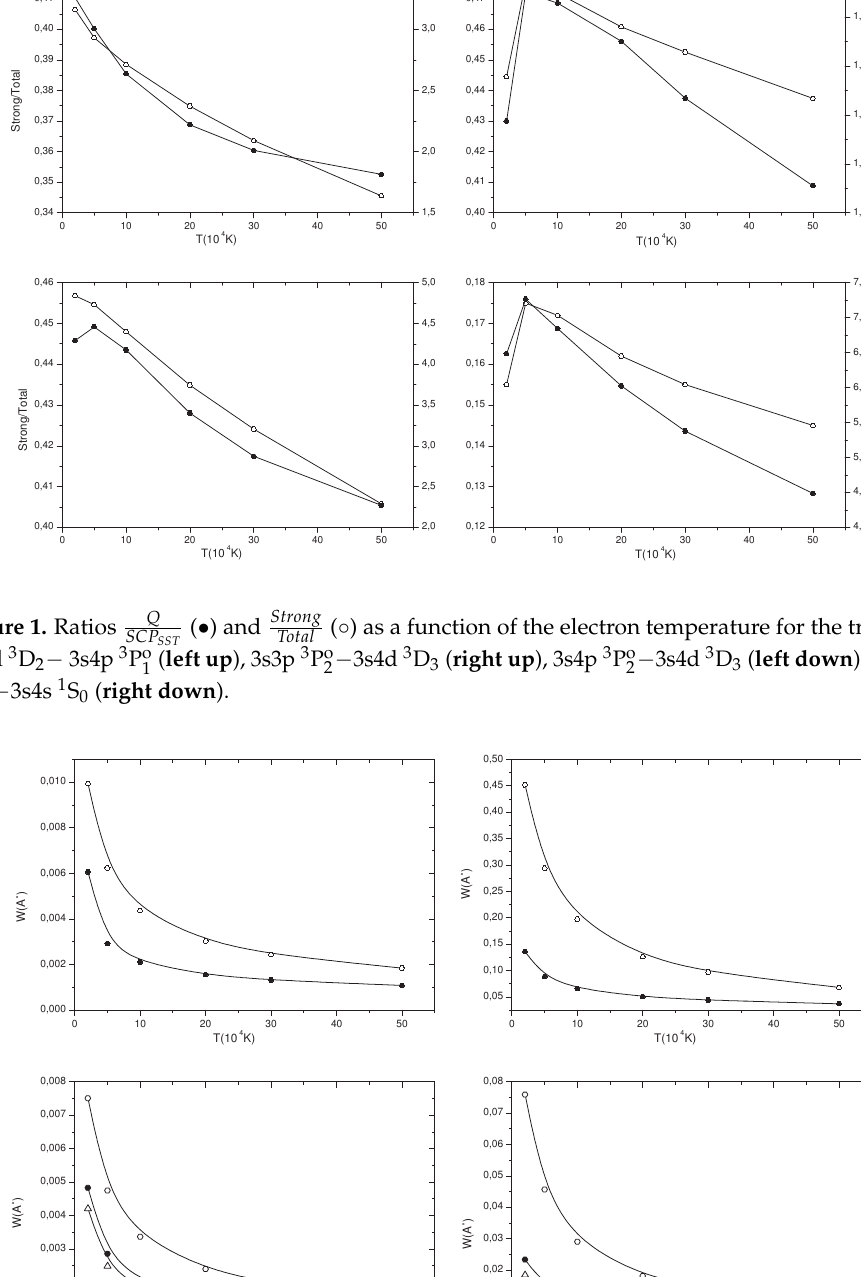
Figure 2. Stark width (FWHM) W as a function of the electron temperature for transitions 3s 2 1 S 0 − 3s4p 1 P o − 3s5s 1 S = 10 17 cm − 3 , and for transitions ( left up ) and 3s4p 1 P o 0 ( right up ) at electron density N e 1 1 3 D − 3s4d 3 D − 3s4p 3 P o 3s3p 3 P o ( right down ) at electron density N e = 10 18 3 ( left down ) and 3s3d 2 2 1 cm − 3 . ◦ : Present quantum results. • : Present SCP results. (cid:52) : SCP results from